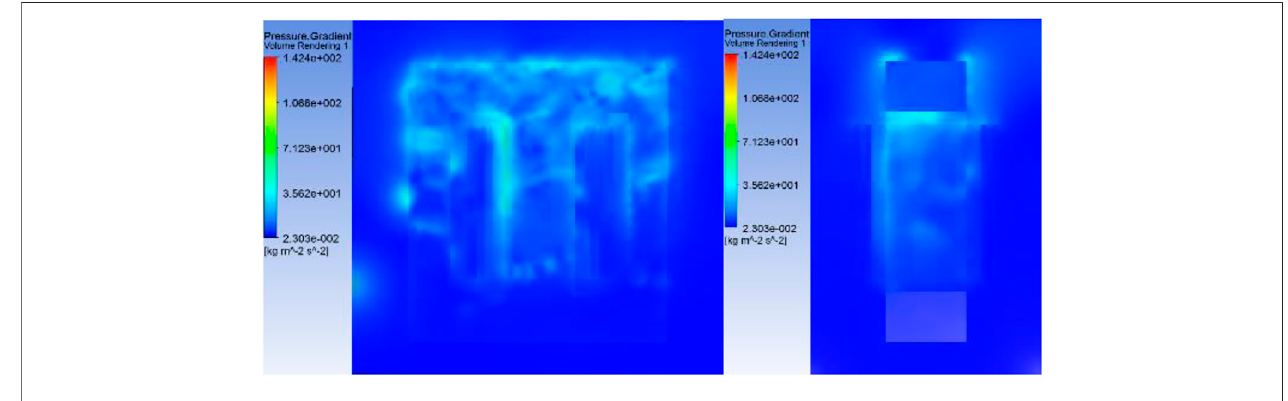
FIGURE 4 | Insulating oil vibration.